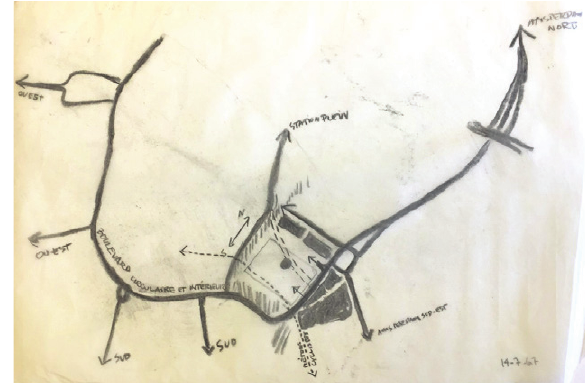
Figure 3. Principal axes and streets diagram (14-07-1967) (Marques da Silva Foundation, RHF archive)